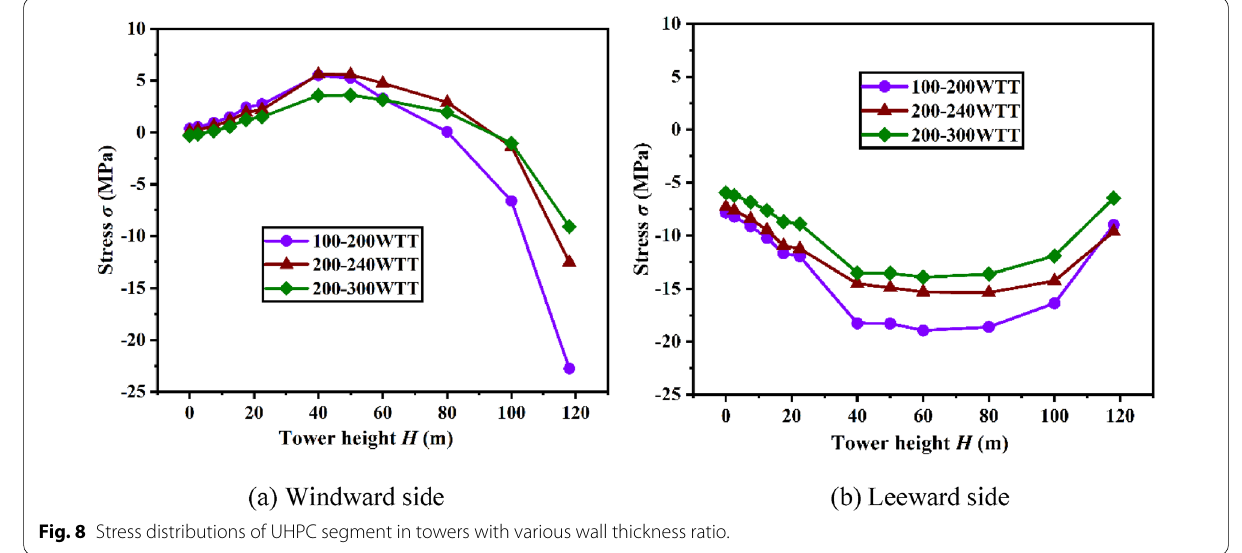
Fig. 8 Stress distributions of UHPC segment in towers with various wall thickness ratio.